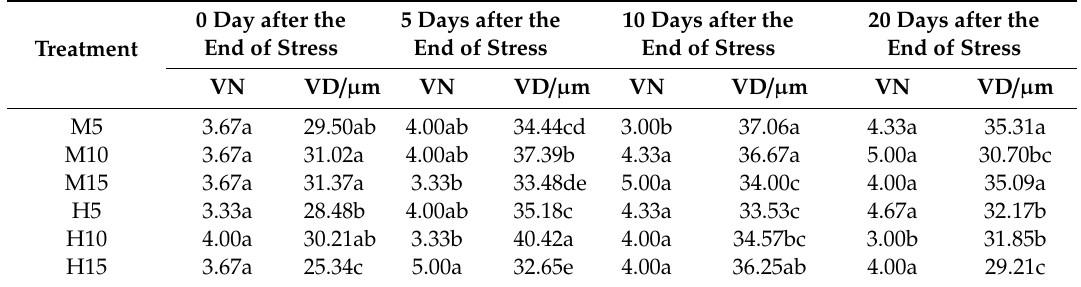
Table 6. The number and diameter of vessels after exposure to high temperature and waterlogging.